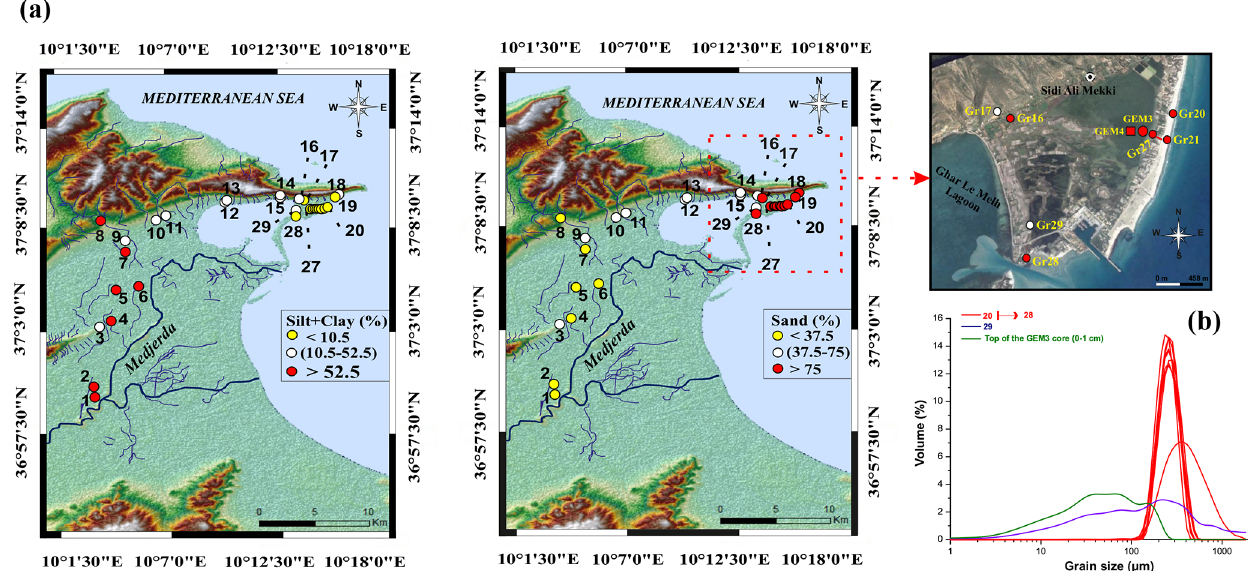
Figure 6. (a) Topographic maps of the sand, silt, and clay percentage distributed in the Medjerda watershed and around the lagoon of Ghar El Meleh (created by Radewane Hout using ArcGIS). (b) Topographic map of the two cores and the different sediment samples collected from Ghar El Meleh lagoon and its surroundings (e.g., © Google Earth). (c) Particle size distributions ( φ < 2000µm) of representative samples around the Ghar El Meleh lagoon.